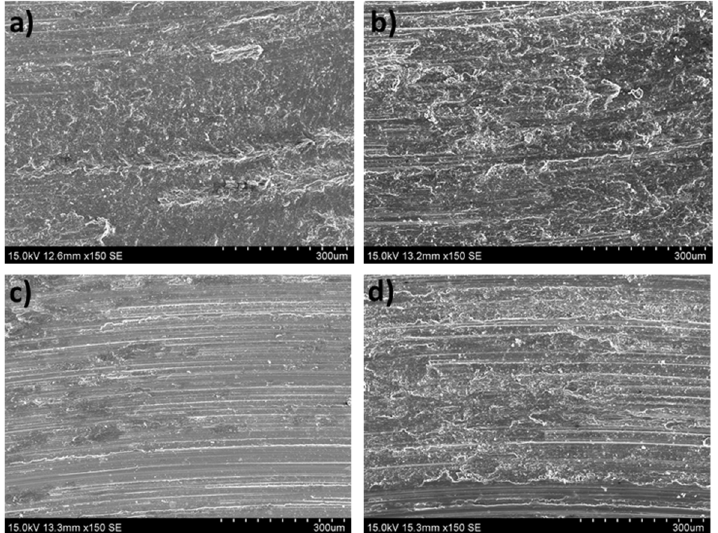
Figure 11. Worn tracks observed for over-aged ZX30 under the different wear conditions: ( a ) 2 N, 0.05 m s − 1 ; ( b ) 20 N, 0.05 m s − 1 ; ( c ) 2 N, 0.1 m s − 1 ; ( d ) 20 N, 0.1 m s − 1 .